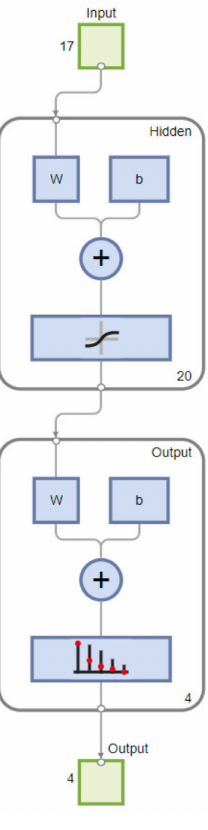
Figure 10. The BPNN network diagram used in this